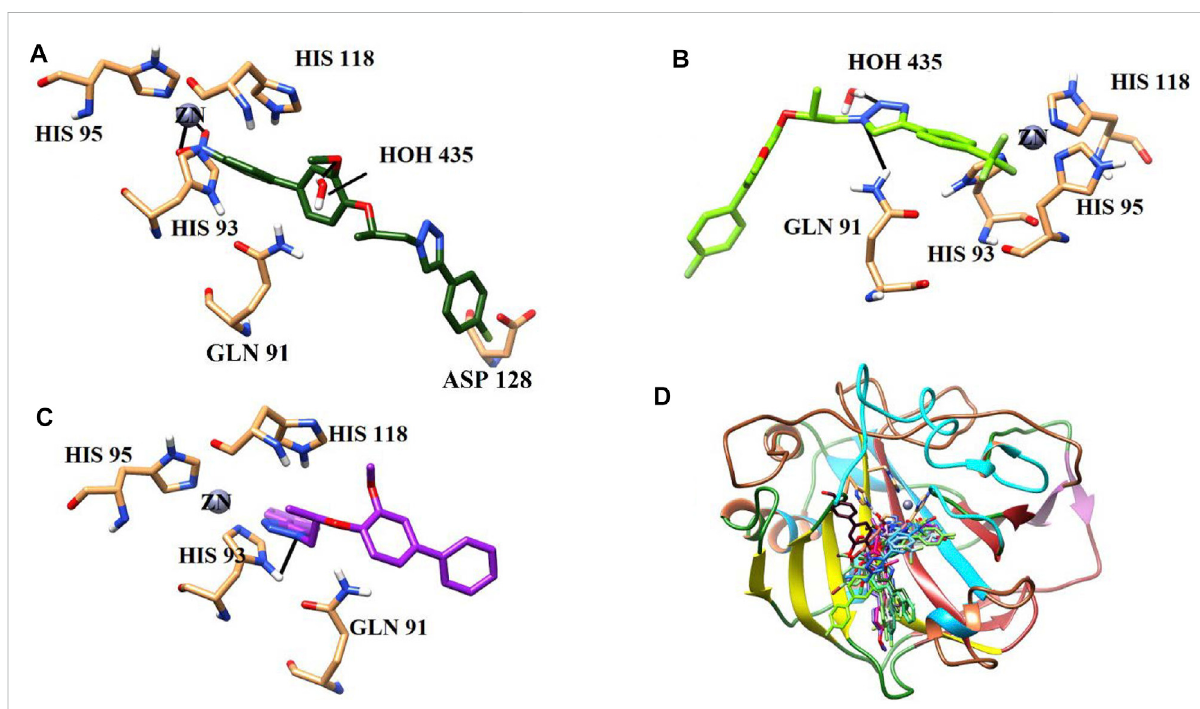
FIGURE 5 Bindingorientationsof (A) mostactivecompound 9i (darkgreenstickmodel), (B) moderateactive 9d (lightgreenstickmodel), (C) leastactive 9f (purple stick model), and (D) all the active compounds are shown in the active site of bCA. The active site residues are shown in coral sticks, and H-bonds are depicted in black